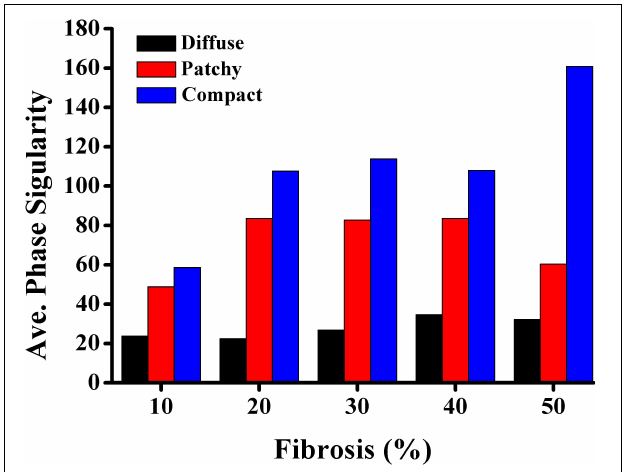
FIGURE 5 | Average number of phase singularities. FIGURE 6 | Average left-ventricle stroke